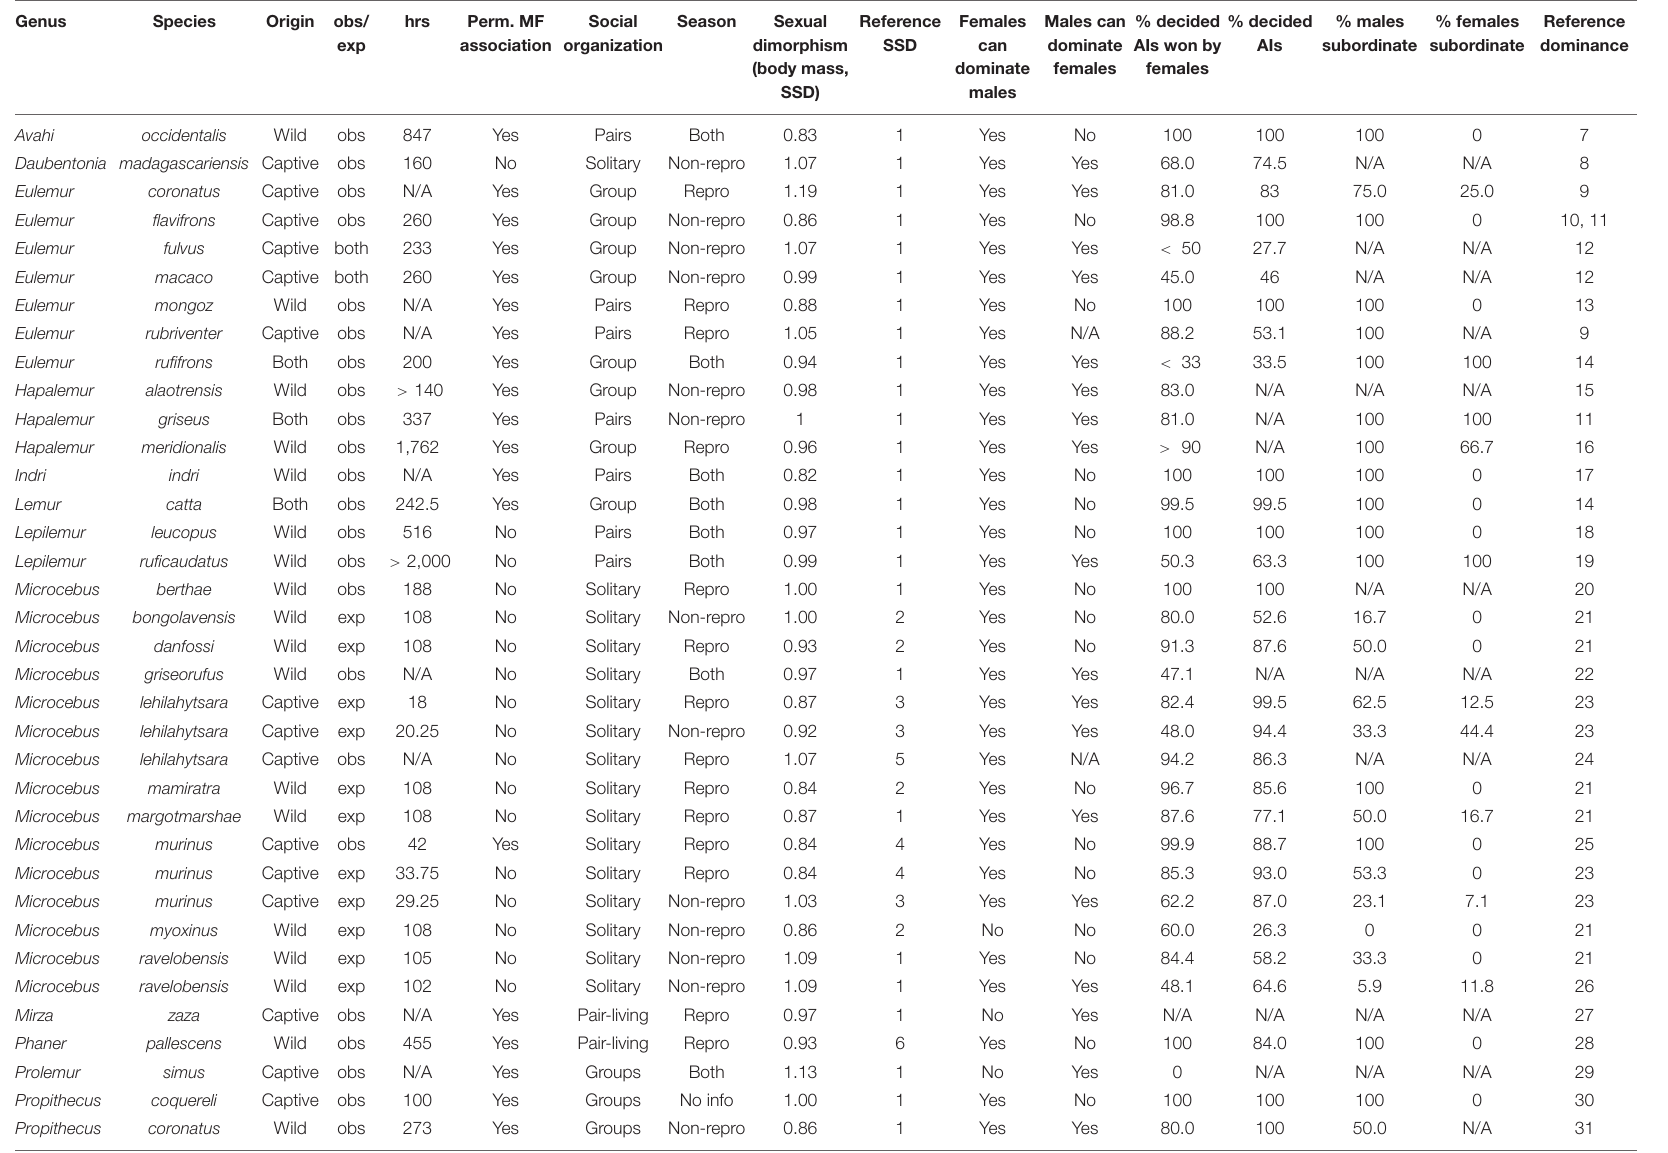
TABLE 1 | Life style, sexual body mass dimorphism, conflict characteristics, and intersexual dominance relationships in lemurs (Lemuriformes).